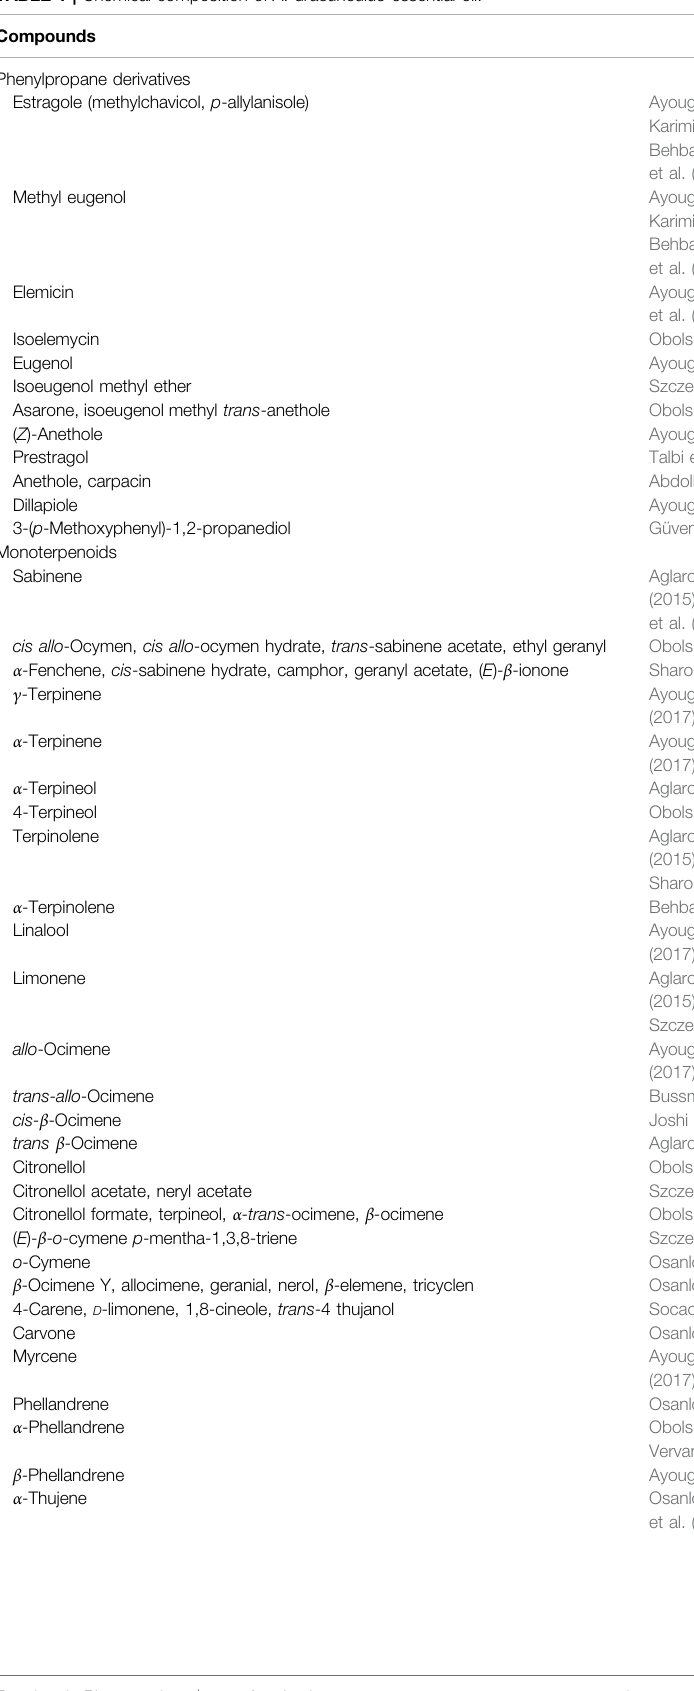
TABLE 1 | Chemical composition of A. dracunculus essential